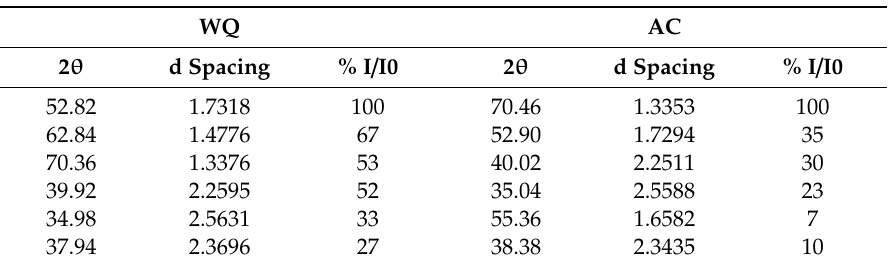
Table 2. XRD analysis.